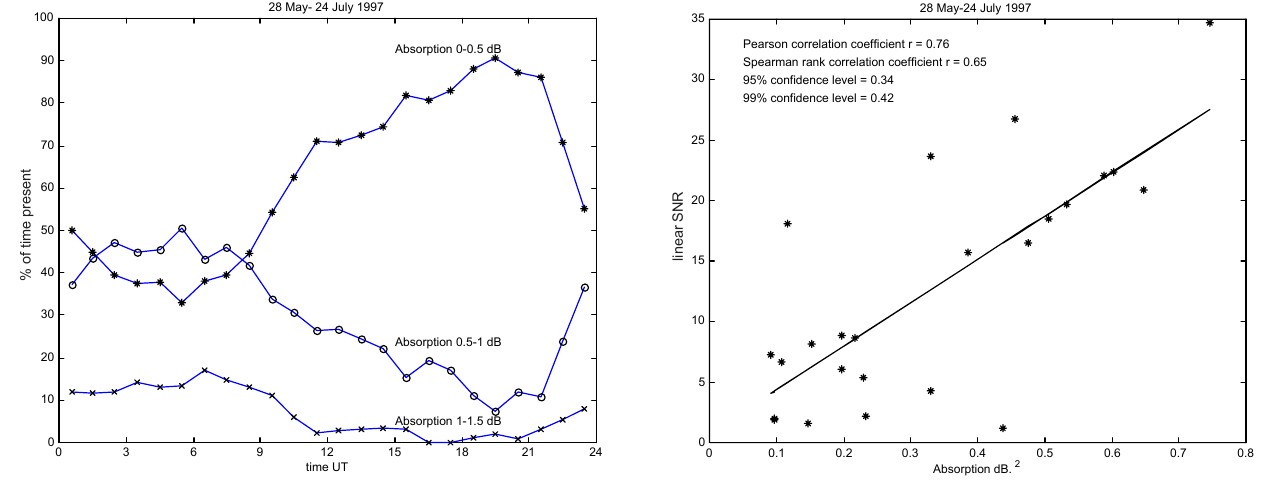
Fig. 2. Occurrence rate of different absorption levels during the period 28 May–24 July 1997 as a function of time of day.